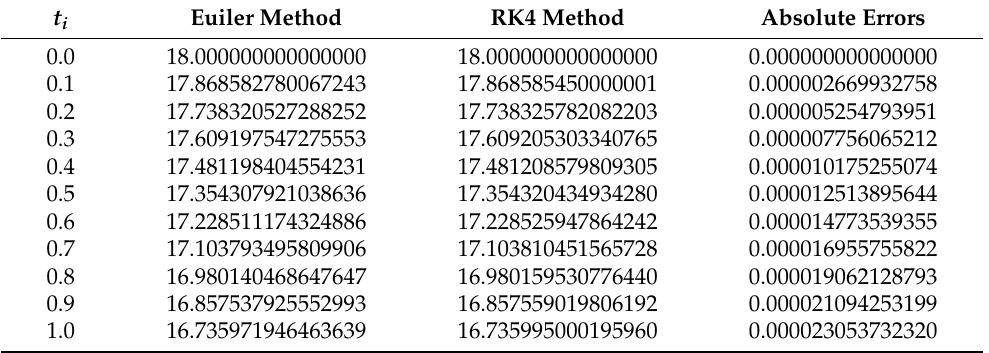
Table 9. Comparison between the results of the modified Euler method and RK4 method for R ( t )